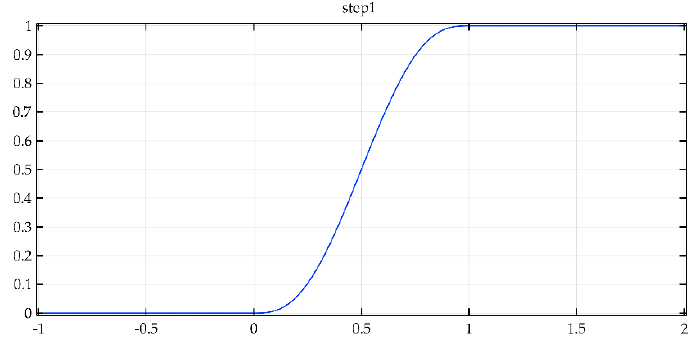
Figure 12. The step function graph used in simulation.